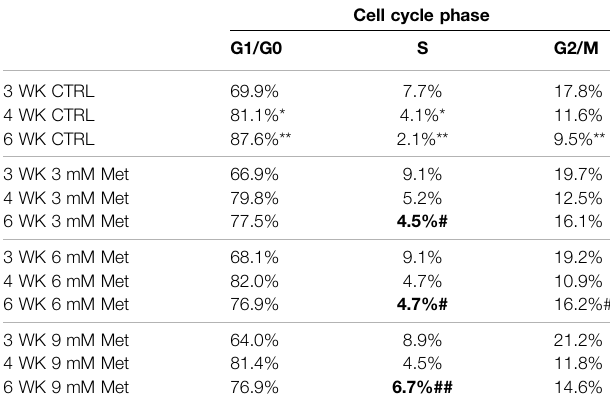
TABLE 1 | Cell cycle